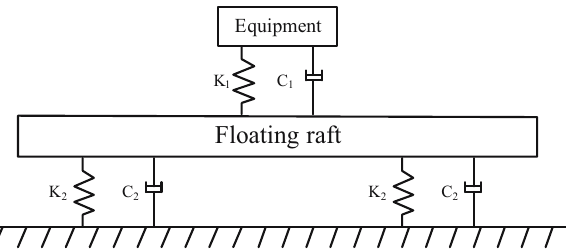
Figure 1: Schematic diagram of fl oating